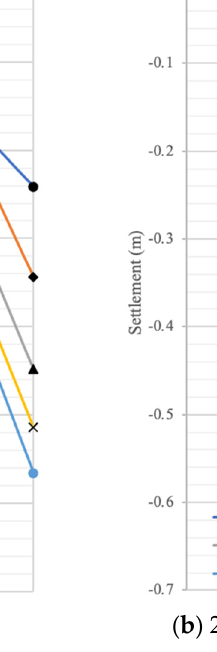
Figure 9. Load–settlement curves (groundwater table 10 m below).